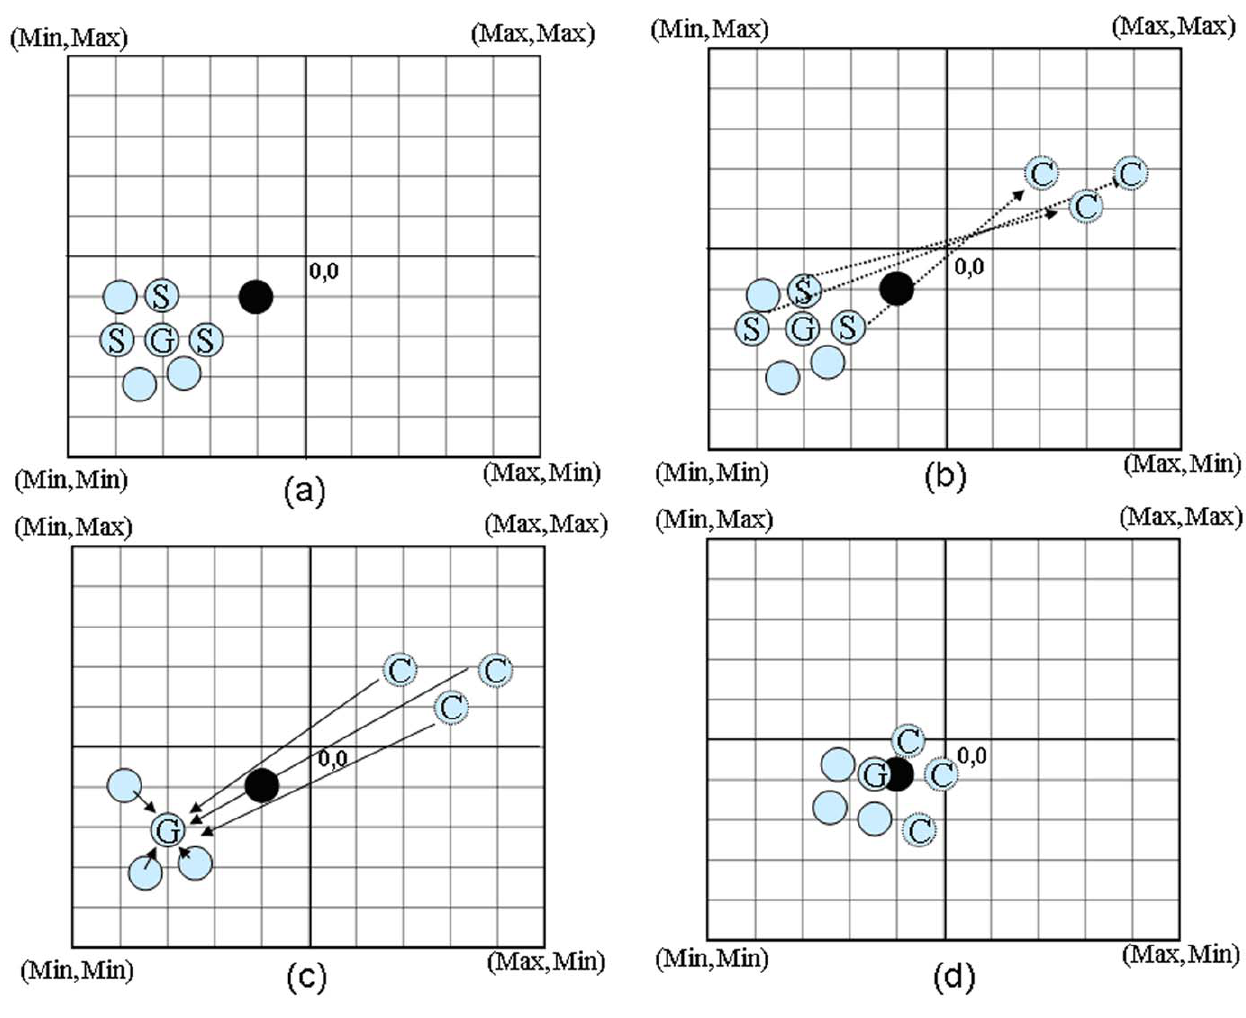
Figure 1. CPSO implementation diagram.